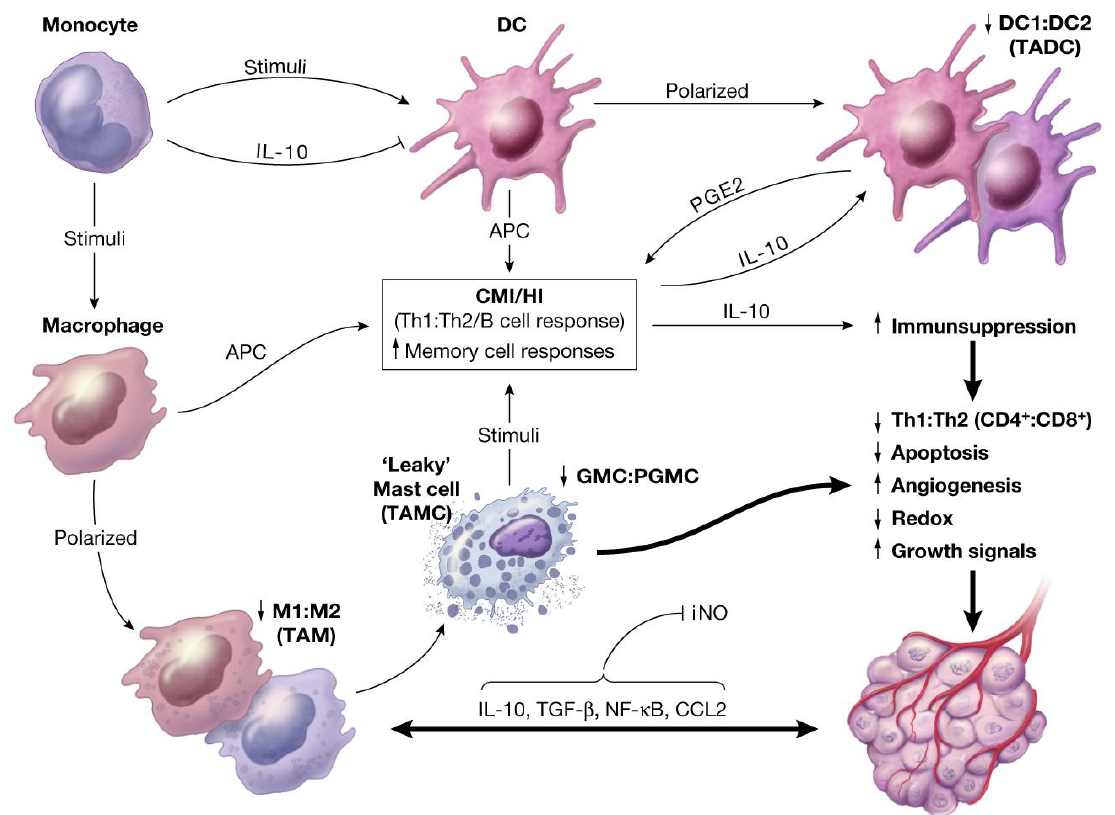
Figure 3. Schematic representation of oxidative stress-induced changes in the balance between inherent polarity (duality, Yin and Yang) of immune responses and the induction of immune suppression in immune-responsive tissues toward tumorigenesis and angiogenesis. Reproduced from Khatami [38] with permission from Informa Healthcare, all rights